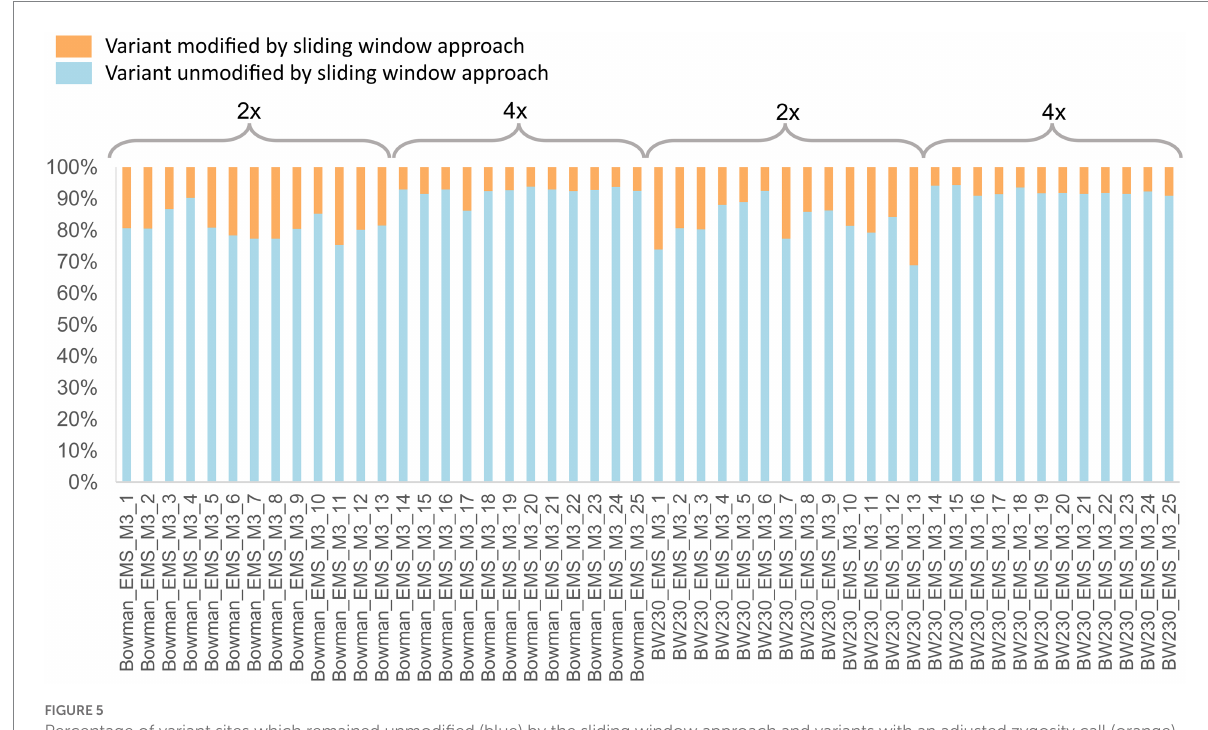
FIGURE 5 Percentage of variant sites which remained unmodified (blue) by the sliding window approach and variants with an adjusted zygosity call (orange) by the sliding window approach. Individuals 1–13 were sequenced to a depth of 2x coverage, while individuals 14–25 were sequenced to a 4× coverage read